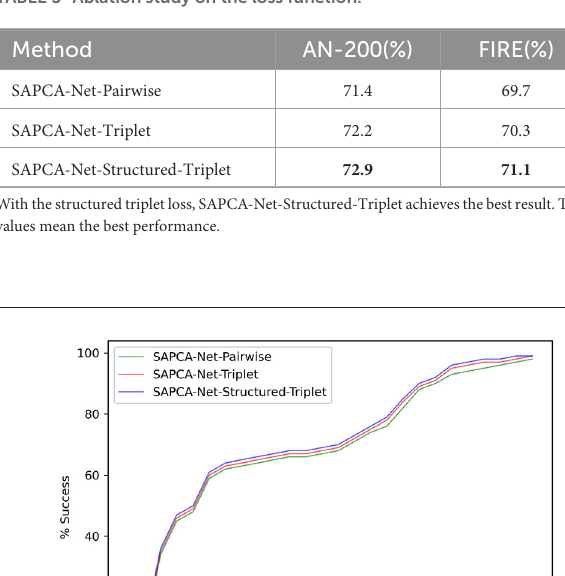
TABLE 3 Ablation study on the loss function.